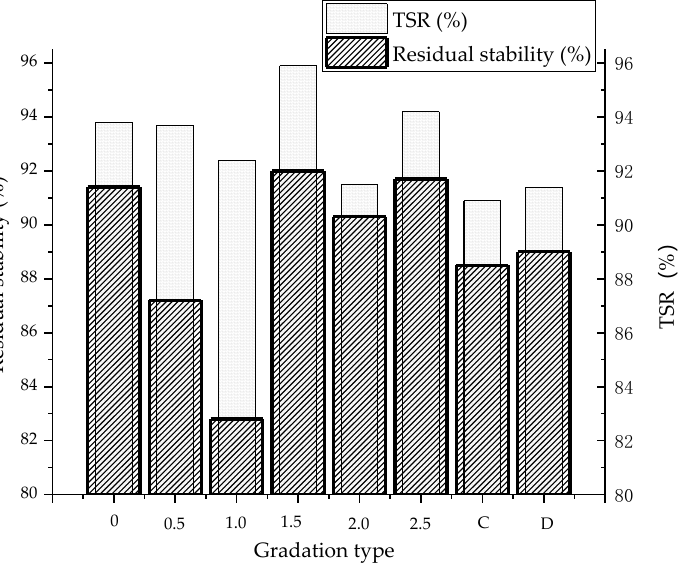
Figure 10. Water stability test results.